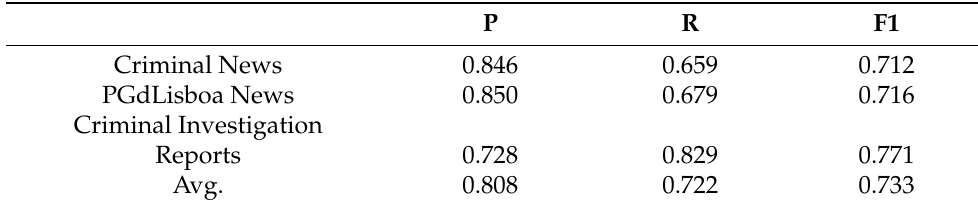
Table 1. Criminal-Related Documents Evaluation.